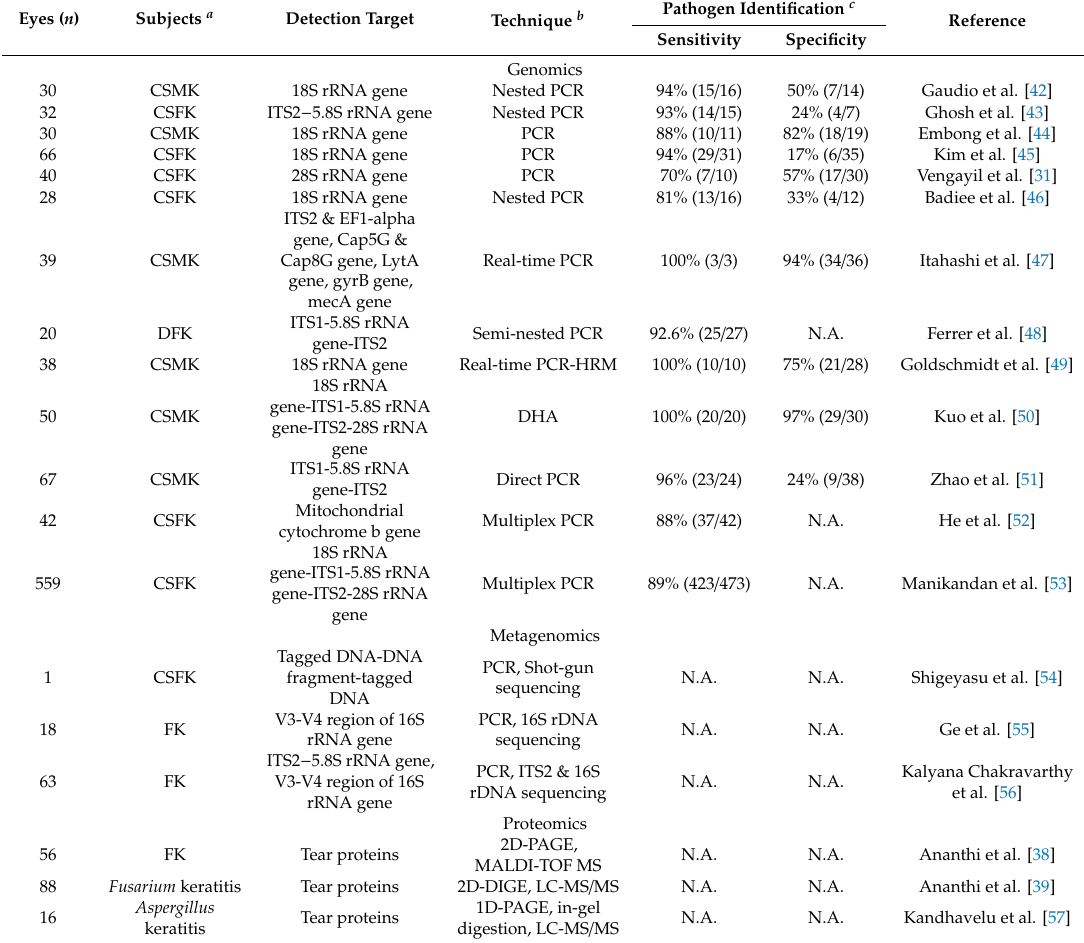
Table 1. Omics approach for diagnosing fungal